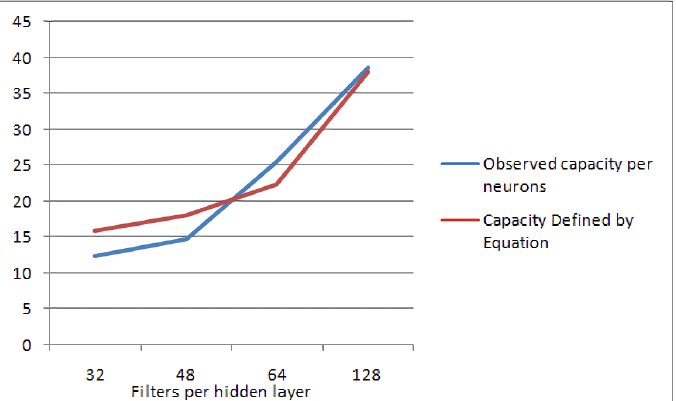
Figure 8. Observed capacity of manually optimized neural network vs. theoretical optimal capac- ity